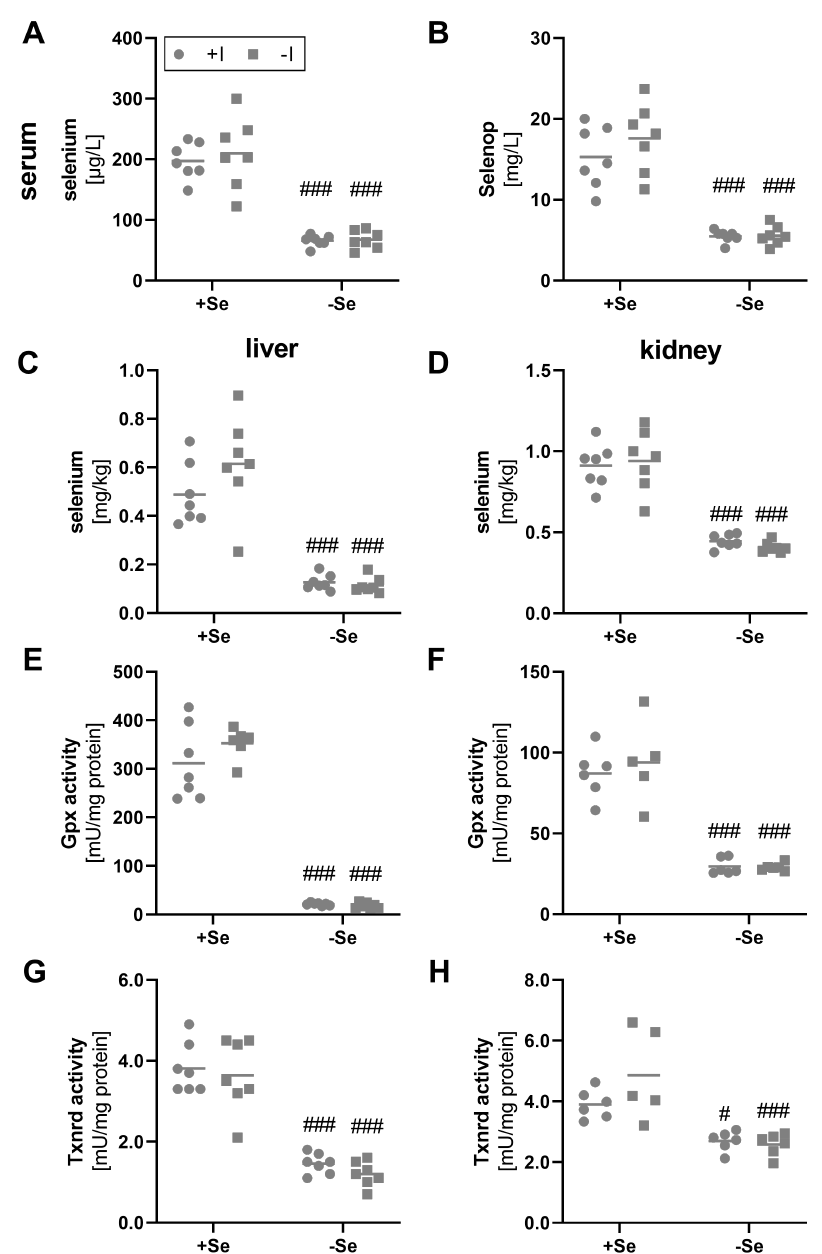
Figure 2. Biomarkers indicating selenium status in serum, liver, and kidney. To evaluate the selenium status, serum and tissue samples from male C57BL/6Jrj mice (n = 5–7) were used, which were supplied with either deficient or adequate amounts of selenium (Se) and iodine (I) for 8 weeks prior to sacrifice. Concentrations of selenium ( A , C , D ) and Selenop ( B ) were determined by ICP- MS/MS in serum ( A , B ), liver ( C ), and kidney ( D ). Further, selenium status was assessed by Gpx ( E , F ) and Txnrd activities ( G , H ), based on NADPH-consuming glutathione reductase-coupled assay and NADPH-dependent reduction of DTNB, respectively, in hepatic ( E , G ) and renal ( F , H ) tissue. Statistical analysis based on Two-way ANOVA and post hoc analysis using Bonferroni’s test with # p < 0.05; ### p < 0.001 versus +